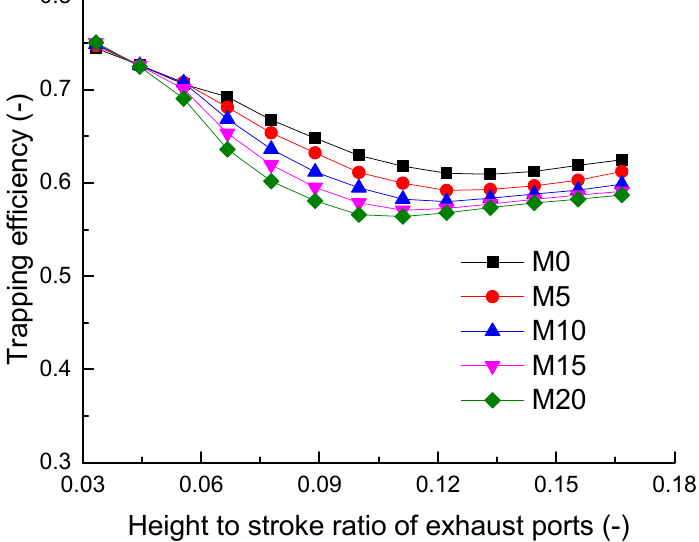
Figure 4. Trapping efficiency for different height to stroke ratios of the intake